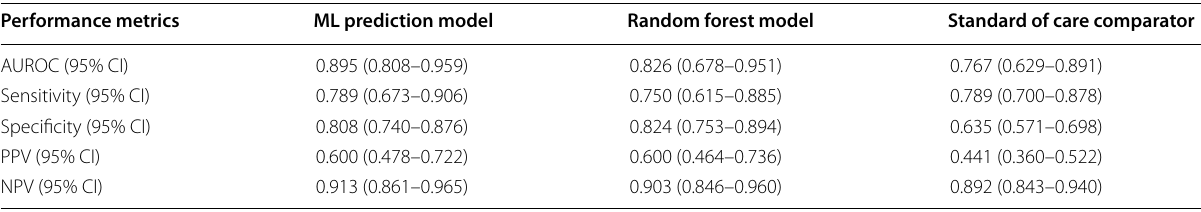
AUROC area under the receiver operator characteristic curve; CI confidence interval; PPV positive predictive value; NPV negative predictive